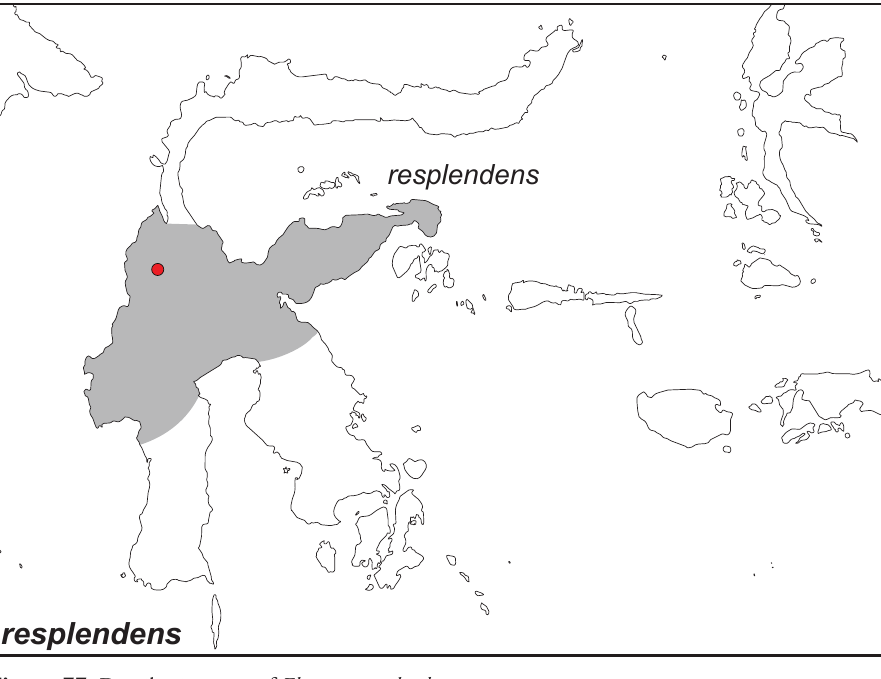
Figure 77. Distribution map of Elymnias resplendens